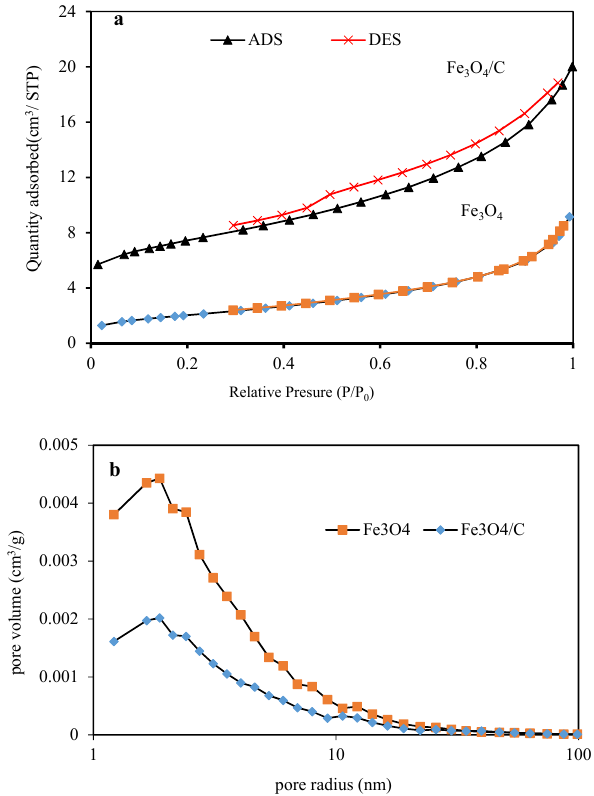
Fig. 7: N adsorption-desorption isotherms (a) and BJH pore-size distribution curves 2